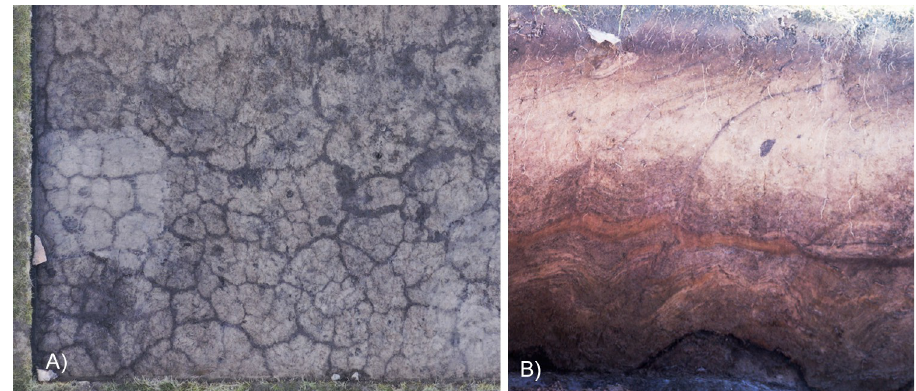
Fig 3. Effects of freeze thaw cycles on the excavation site. A) Criss crossing cracks in the planigraphy. B) Wave patterns in the stratigraphy.